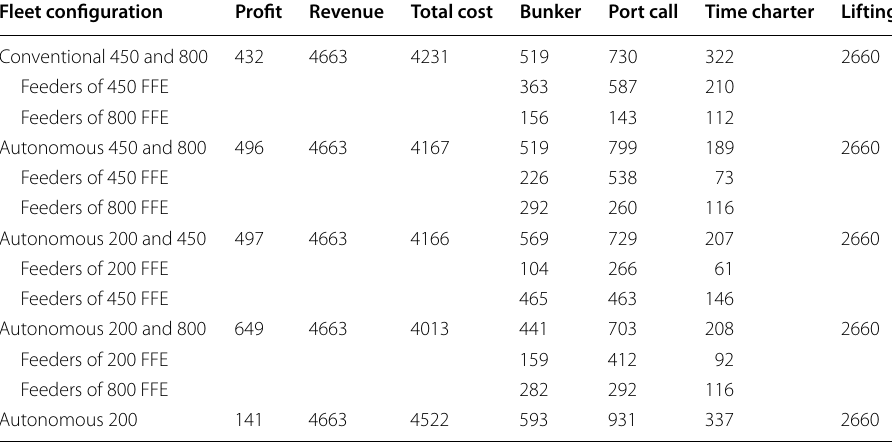
Table 8 Results of the static LSNDP for the high demand scenario (in thousand USD) Fleet configuration